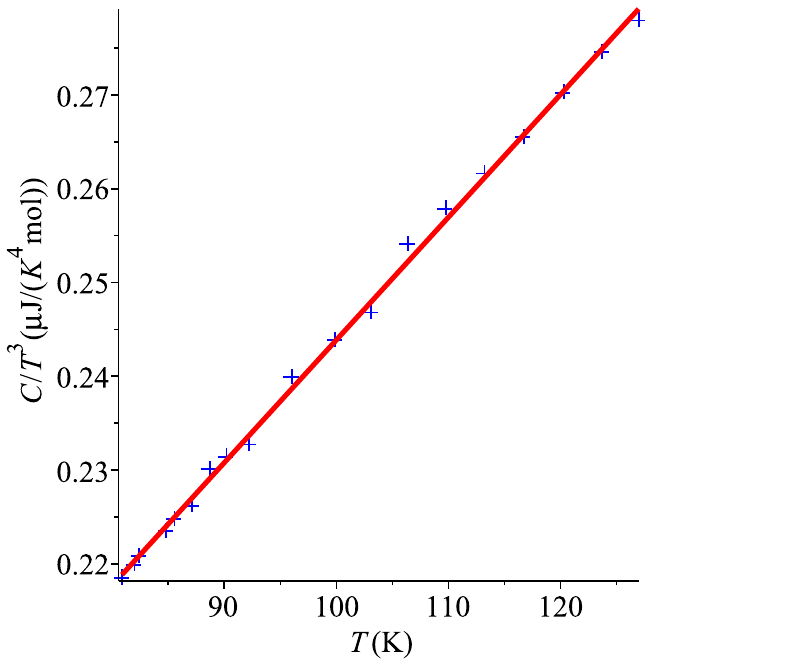
Figure 3. QLT regime of natural diamonds, Ref. 25